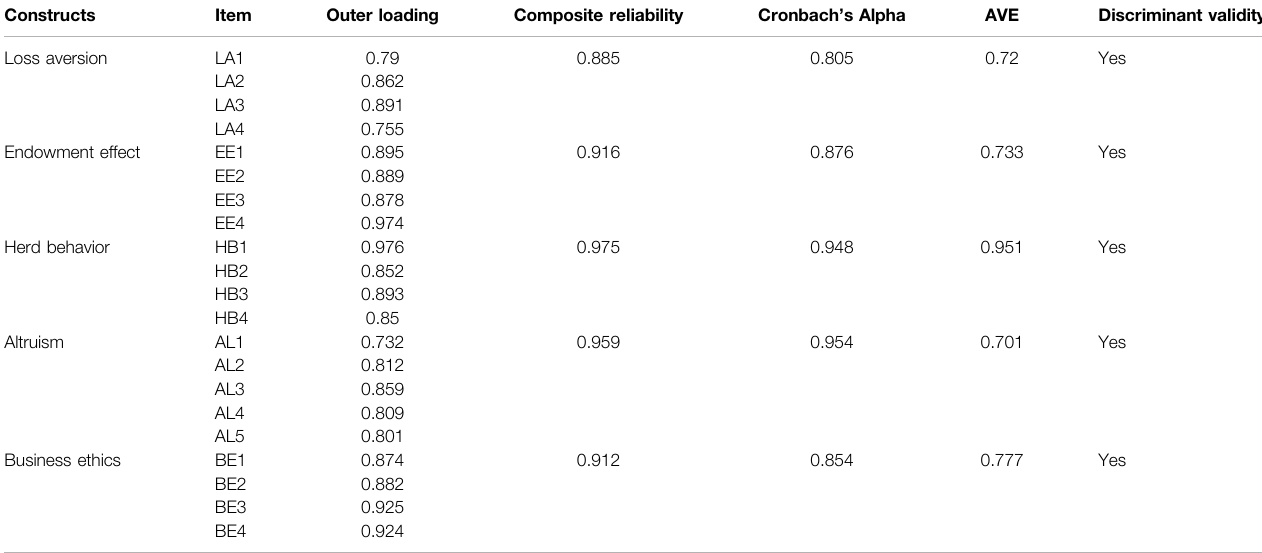
TABLE 5 | Measurement model results. Constructs